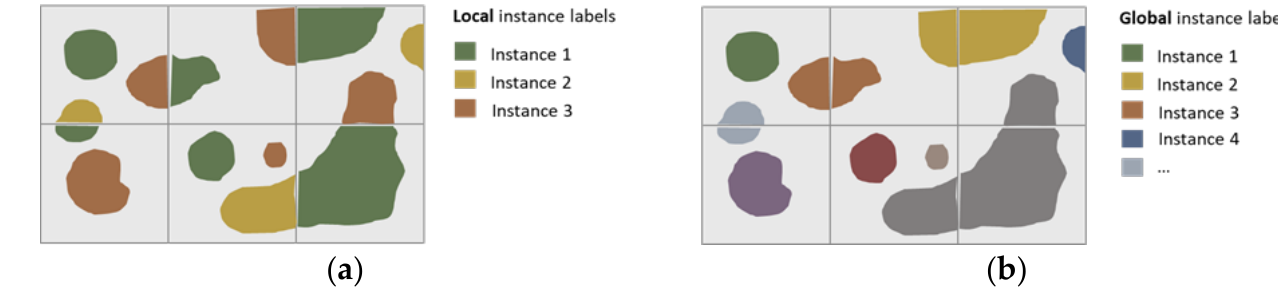
Figure 12. Local instance labels per tile ( a ) vs. global instance labels of merge result ( b ).